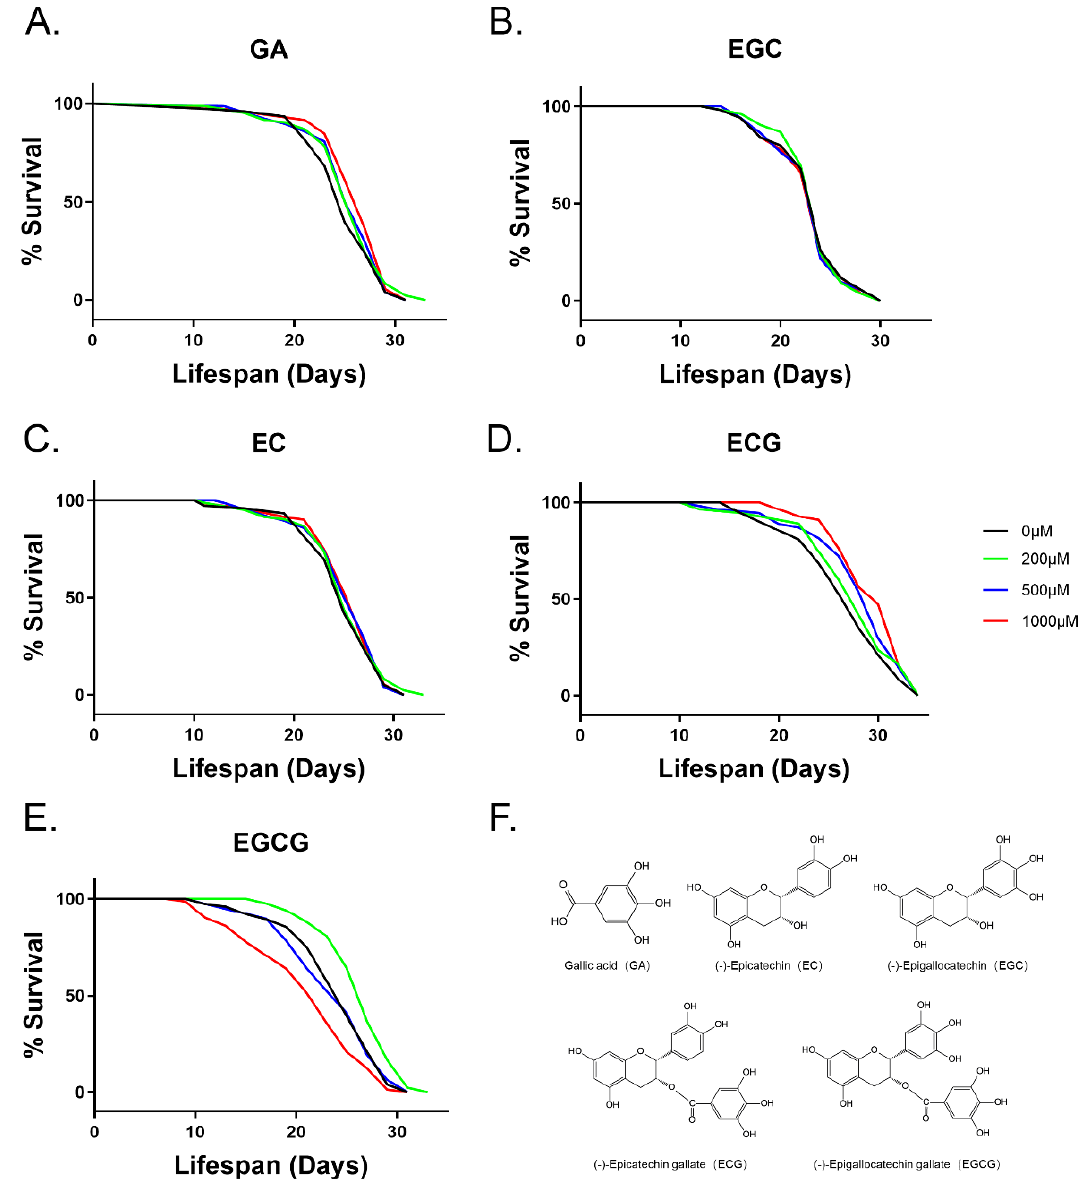
Figure 1. Survival of wild-type C. elegans treated with polyphenols. ( A ) GA, ( B ) EGC, ( C ) EC, ( D ) ECG, and ( E ) EGCG tested at different concentrations (200, 500, and 1000 µ M) for their ability to change the lifespan of the worms. ( F ) Molecular formulae of GA, EGC, EC, ECG, and EGCG. Survival rates were recorded every other day until all worms died ( n = 90–105 worms/treatment). Statistical analysis using the log-rank (Mantel–Cox) test showed that the changes in the survival curves of 500 and 1000 μ M ECG compared with the control group were significant ( p < 0.05).